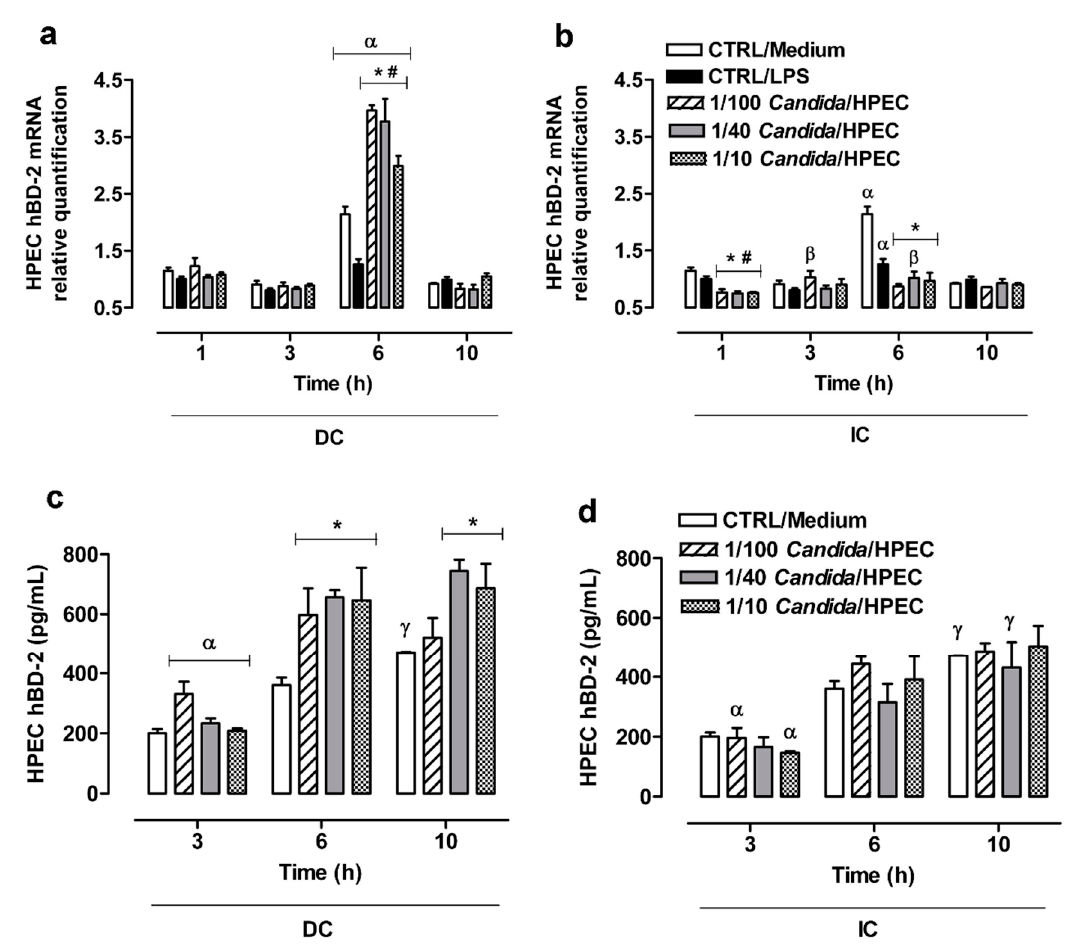
Figure 5. Significant β -defensin 2 ( hBD-2 ) expression by human palate epithelial cells (HPECs) was induced by C. albicans infection. ( a , b ) Regulation of hBD-2 mRNA expression in HPECs after direct (DC) or indirect contact (IC) with C. albicans in di ff erent ratios over time. The mRNA levels were quantified by RT-qPCR using gene expression assays and normalized with β -globulin as the reference gene. ( c , d ) hBD-2 secretion by HPECs after DC and IC with C. albicans over time. (*) p < 0.007 compared to unchallenged cells (CTRL / Medium) at the same time. (#) p < 0.047 compared to CTRL / LPS at the same time. ( α ) p < 0.026 compared to all other times. ( β ) p < 0.001 compared to 1 h. ( γ ) p < 0.005 compared to 3 h. Results are expressed as the mean ± SEM of at least three independent experiments performed in triplicate with the factorial ANOVA contrast